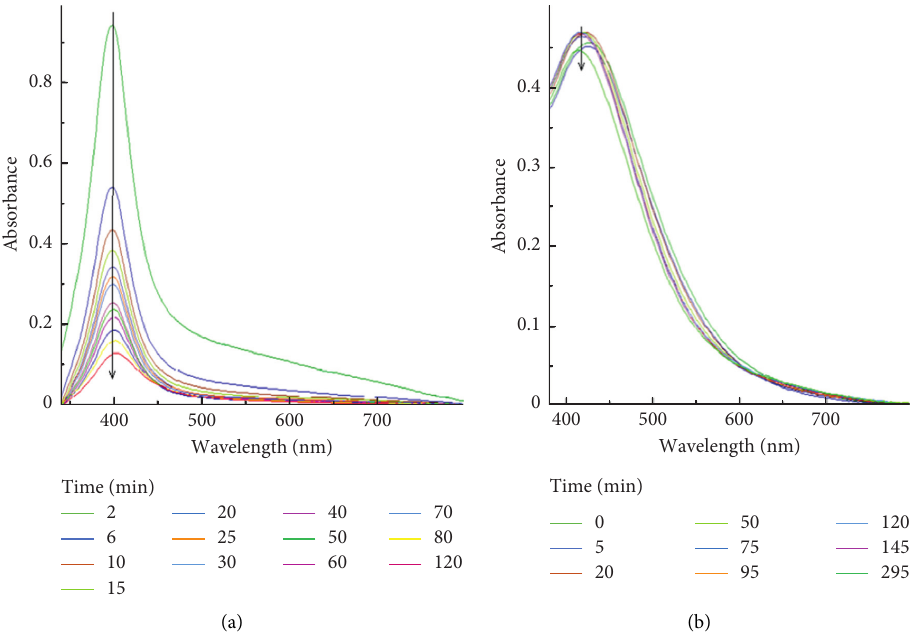
Figure 7: Time-dependent UV-vis spectra of AgNPs solution in the presence of 0.1 M NaCl. (a) AgNPs prepared using NaBH trisodium citrate; (b)